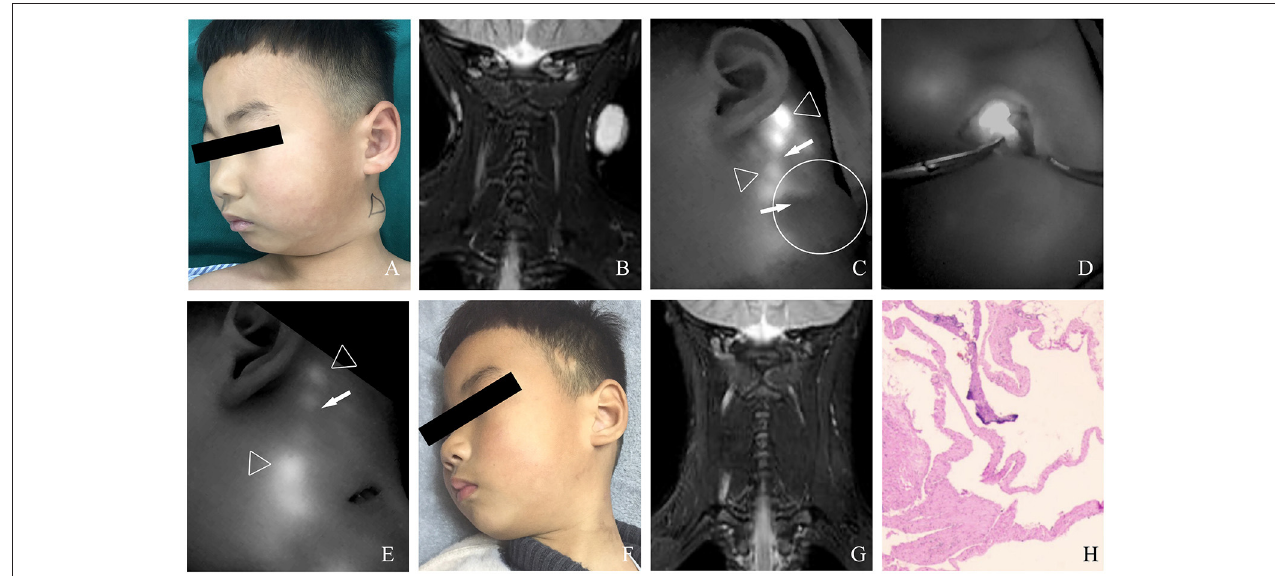
FIGURE 3 | (A) A 4-year-old male patient with macro cLM of left neck preoperatively. (B) MRI preoperatively. (C) A normal lymph vessel from the left temporal scalp ran into the posterior auricular region, from which another afferent lymph vessel was observed flowing into the lesion cite. (D) The cLM lesion confirmed by ICG lymphography during surgery. (E) No inflow visualization or lymphatic leak on the previous detected site after inflow occlusion. (F) Ten months postoperatively, complete regression of cLM met the criterion of excellent curative effect. (G) MRI postoperatively. (H) Pathology postoperatively. Arrow head , lymph vessel; circle , region of cLM; hollow triangle , lymph node.